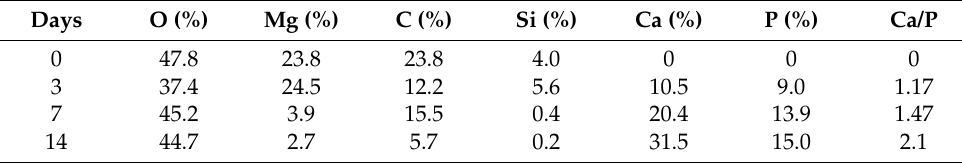
Figure 5. SEM micrographs of the UMAO/PLGA/NG coating in SBF for ( a ) 0, ( b ) 3, ( c ) 7, and ( d ) 14 days. Table 2. Elemental composition of the UMAO/PLGA/NG coating in